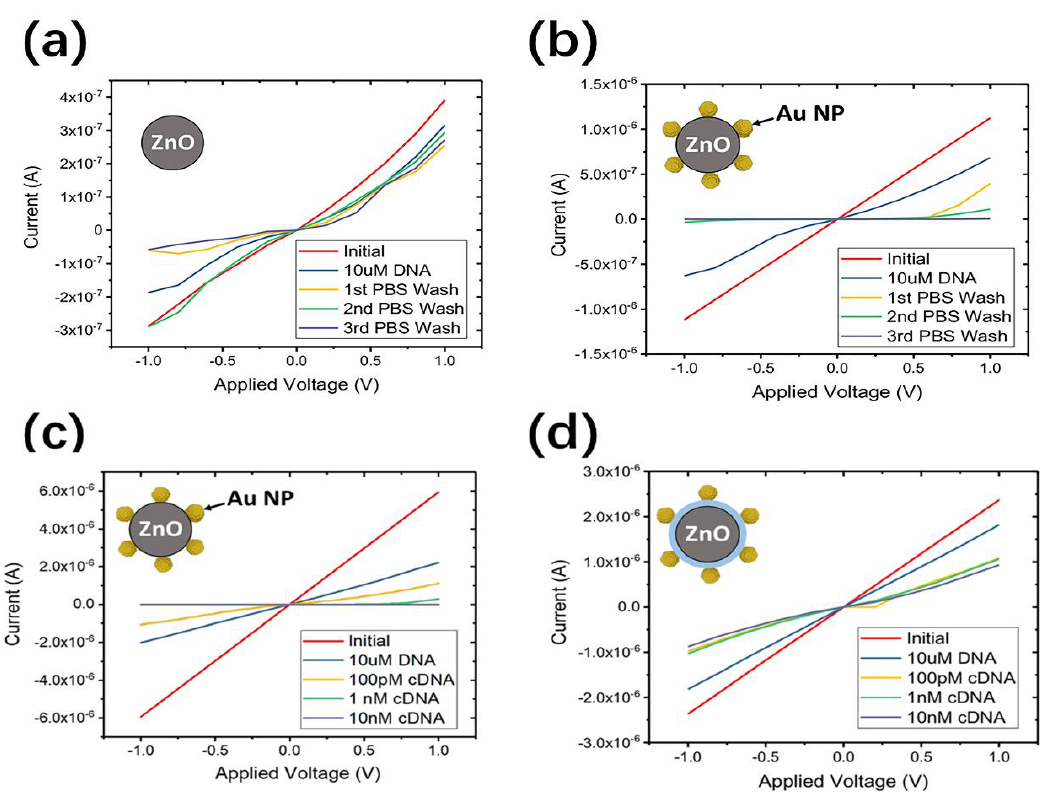
Figure 9. The response current-voltage curves of ( a ) bare, ( b , c ) Au NP decorated and ( c ) HfO 2 Passivated ZnO NW sensors with phosphate bufered solution (PBS) solution or cDNA exposure. HfO 2 passivation limits the change of NW conductivity with solution exposure ( c ), and AuNP modification maintains the sensitivity to DNA ( d ) [102].